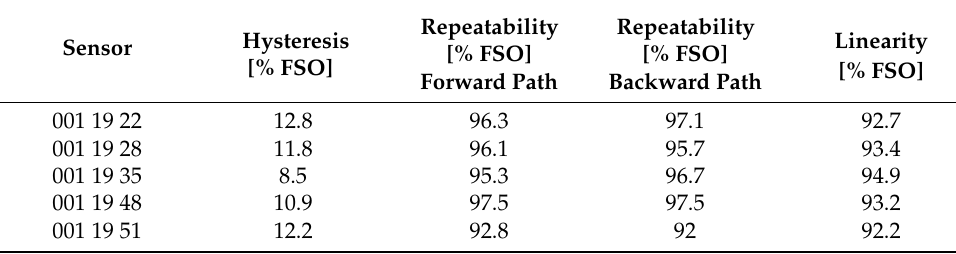
Table 3. Evaluated sensors’ repeatability and linearity and sensor/test bench hysteresis.